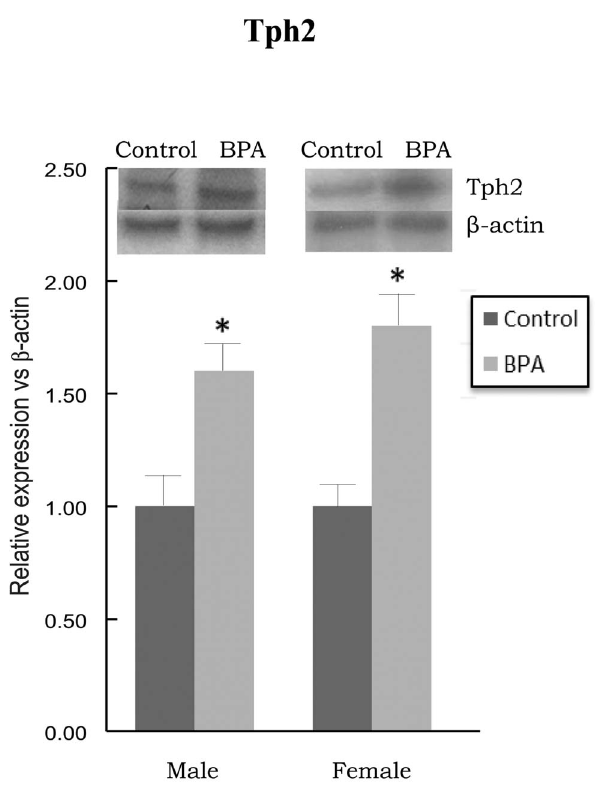
Figure 5. Effects of BPA on protein levels of tryptophan hydroxylase type 2 (Tph2) in prefrontal cortex of BPA-treated male and female rats and their respective controls. * at least p , 0.05 vs. their controls.